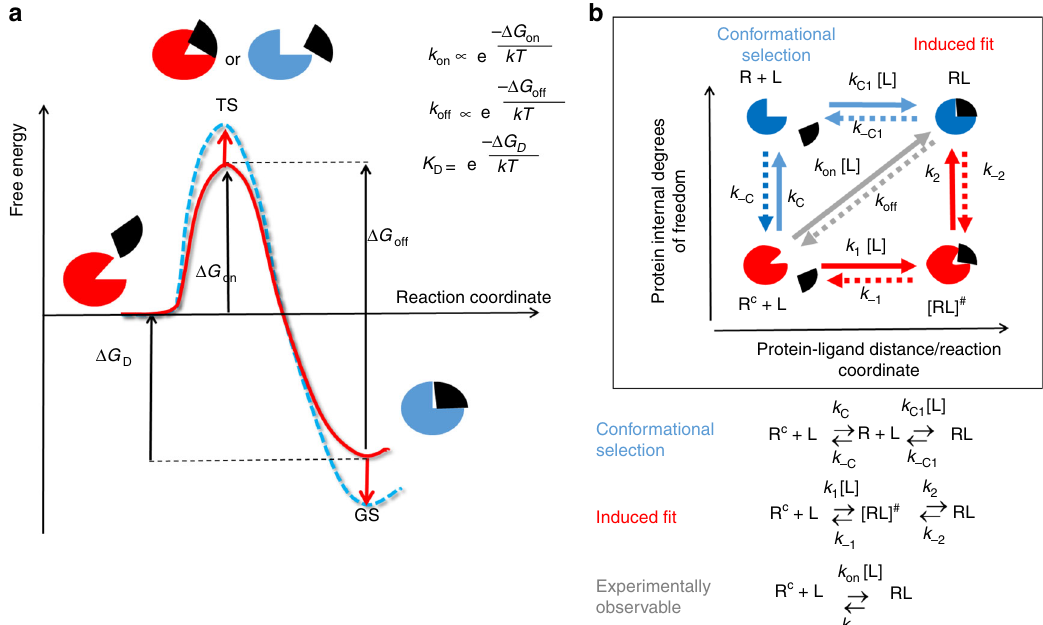
Fig. 1 Models of drug – target binding. a Schematic diagram of a one-barrier drug – target binding free energy pro fi le. A one-step model with one free energy barrier is used to derive the experimental rate constants. The fi gure and equations show how the steady-state rate constants relate to the free energy differences shown. The residence time of a drug bound to its target, τ (which is the reciprocal of the rate constant for dissociation of the drug – target complex, k off ), results from the “ difference ” in free energy between the transition state (TS) and the bound ground state (GS), Δ G off . The red arrows indicate that prolongation of the τ can be achieved by stabilizing the GS (increasing the magnitude of Δ G D ), destabilizing the TS (increasing Δ G on ) or a combination of both (i.e., K off / e (cid:2) Δ G off kT ¼ K D e (cid:2) Δ G on kT ). b Diagram schematically illustrating different mechanisms of drug binding involving protein conformational changes. R and R C denote two different conformations of the protein, the latter requires conformational changes for ligand binding. These may occur by conformational selection (blue path) or by induced fi t upon formation of an encounter complex [RL] # (red path), or by a combination of the two mechanisms. Binding proceeds through an energetically unfavorable intermediate state (TS in panel A or a local minimum in a 2 (or more)-step binding free energy pro fi le) that, in the conformational selection and induced fi t mechanisms, corresponds, respectively, to the R+L or [RL] # state of the system); the fi nal complex is denoted by [RL]. k C/ – C and k 2/ − 2 are the rates of intrinsic and ligand-induced protein conformational transitions, respectively;